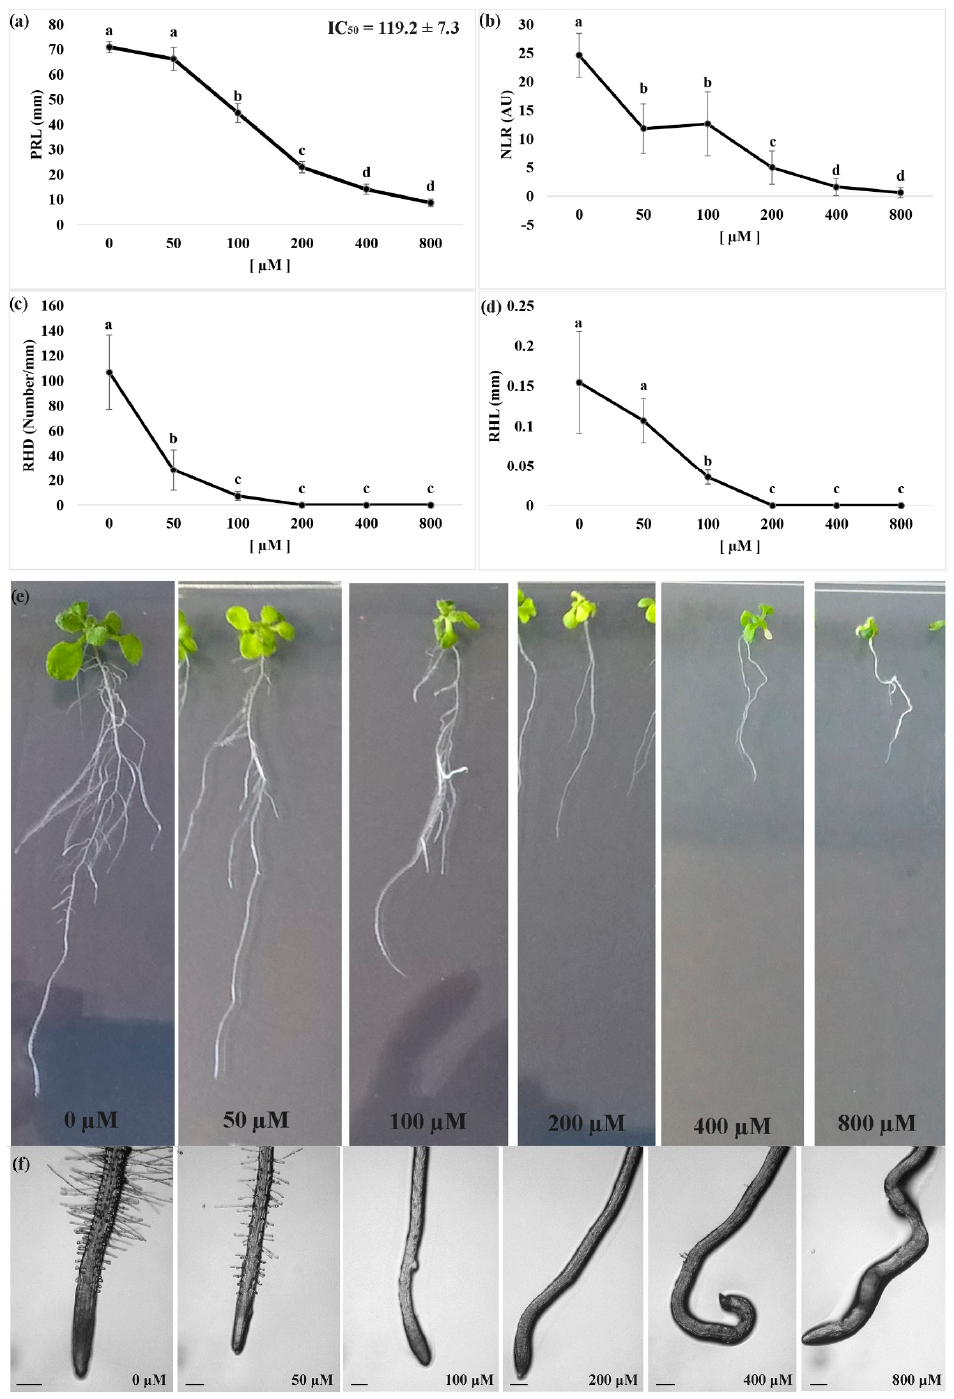
Figure 1. Dose response curve of Arabidopsis seedlings treated with di ff erent doses of nerolidol (0 µ M–800 µ M). ( a ) Primary root length (PRL); ( b ) number of lateral roots (NLR); ( c ) root hair density (RHD); ( d ) root hair length (RHL); ( e ) e ff ects of di ff erent doses of nerolidol on root morphology, and ( f ) root tips of Arabidopsis seedlings treated for 14 d with nerolidol. Data are expressed as mean ± SD. Di ff erent letters indicate significant di ff erences observed among treatments at p ≤ 0.05 (LSD test). n = 5 for PRL and NLR. n = 20 for RHD. Root tips images were photographed using an Olympus stereo microscope, with a 40 × magnification. Scale bars in Figure 1f = 200 µ